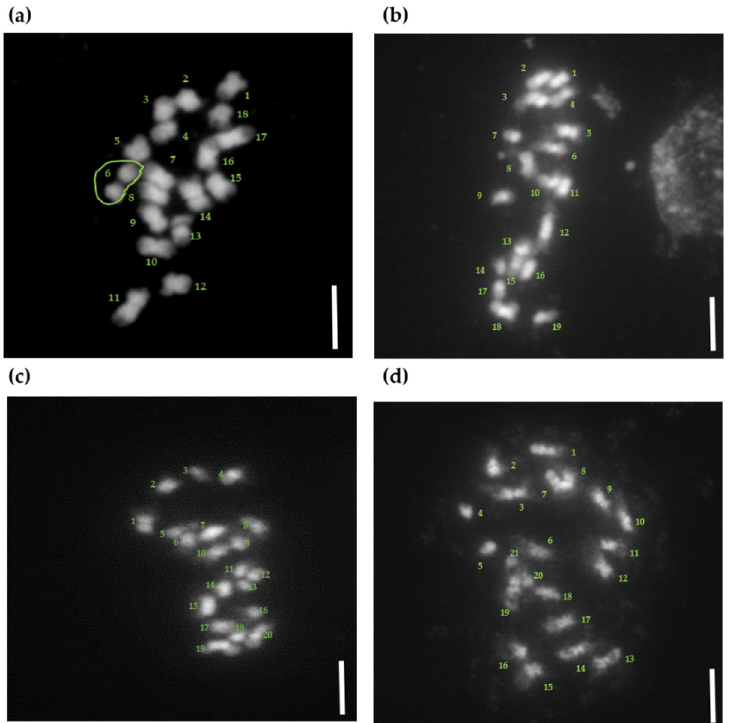
Figure 6. Chromosomal analysis of plants obtained through sour orange anther culture. ( a ) Diploid plants (2n:18); ( b ) Aneuploid plants (2n:19); ( c ) Aneuploid plants (2n:20); ( d ) Aneuploid plants (2n:21). Numbers in green indicate chromosome numbers; scale bar = 5 µm.